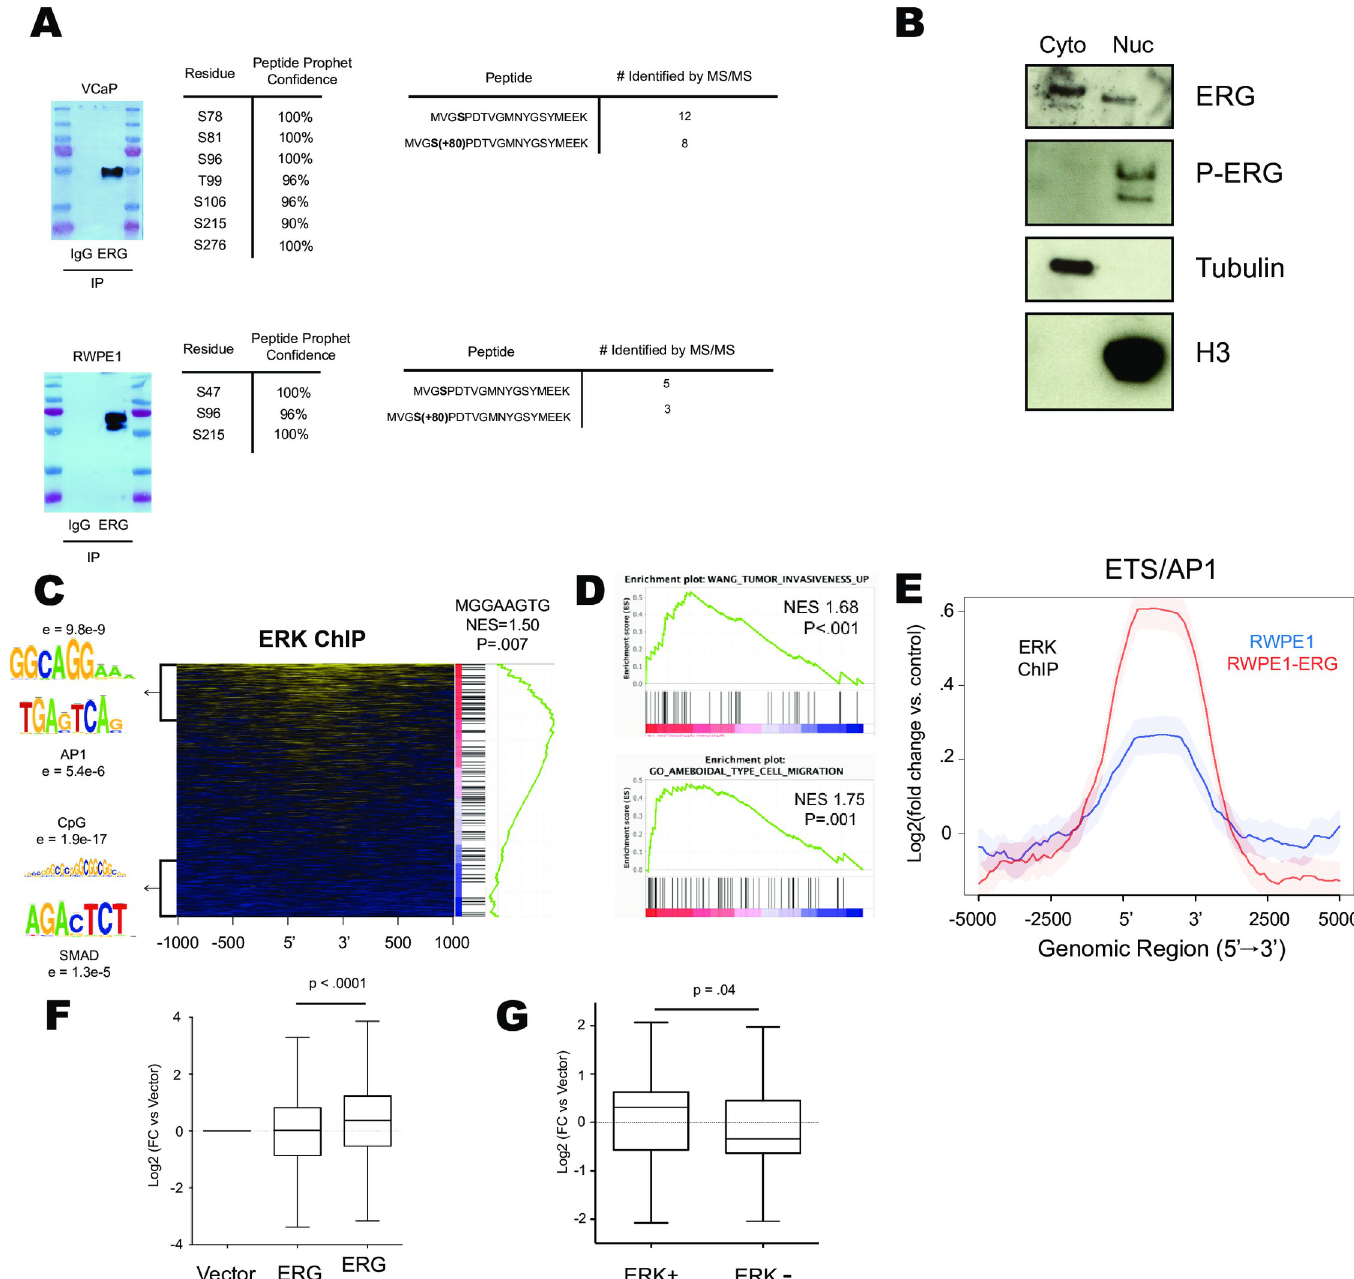
Fig 2. Ras/ERK signaling occurs at ETS/AP1 genomic locations to regulate cell migration. (A) MS/MS analysis of ERG immunoprecipitated from VCaP and RWPE-ERG cells. Data tables show phospho-residue number of ERG NCBI Isoform 1 and compares number of apo/phospho peptides with coverage of S96. (B) Cytoplasmic/Nuclear fractionation of RWPE-ERG immunoblotted for indicated proteins. (C) Heatmap of ERK ChIP-Seq data centered on ERG bound regions [15] depicting motifs over-represented in the top 500 ERK enriched and bottom 500 ERK depleted genes and GSEA analysis of ERK enrichment across ERG bound regions run for motif analysis. (D) GSEA analysis of ERK ChIP-Seq data enrichment ranked on ERG bound regions. (E) ERK ChIP-Seq data centered on consensus ETS/AP1 motifs previously found to be ERG bound in RWPE1. (F) Log2(FC) of nearest genes bound by ERG in RWPE1 cells determined by ChIP-Seq in cells expressing ERG or ERG S96E. (G) Log2(FC) of nearest gene to ERG alone or ERG/ERK co-bound regions.